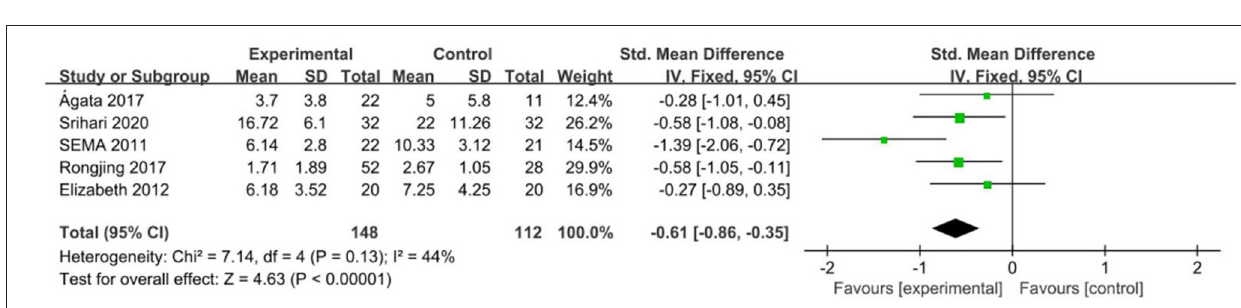
Frontiers in Cardiovascular Medicine |